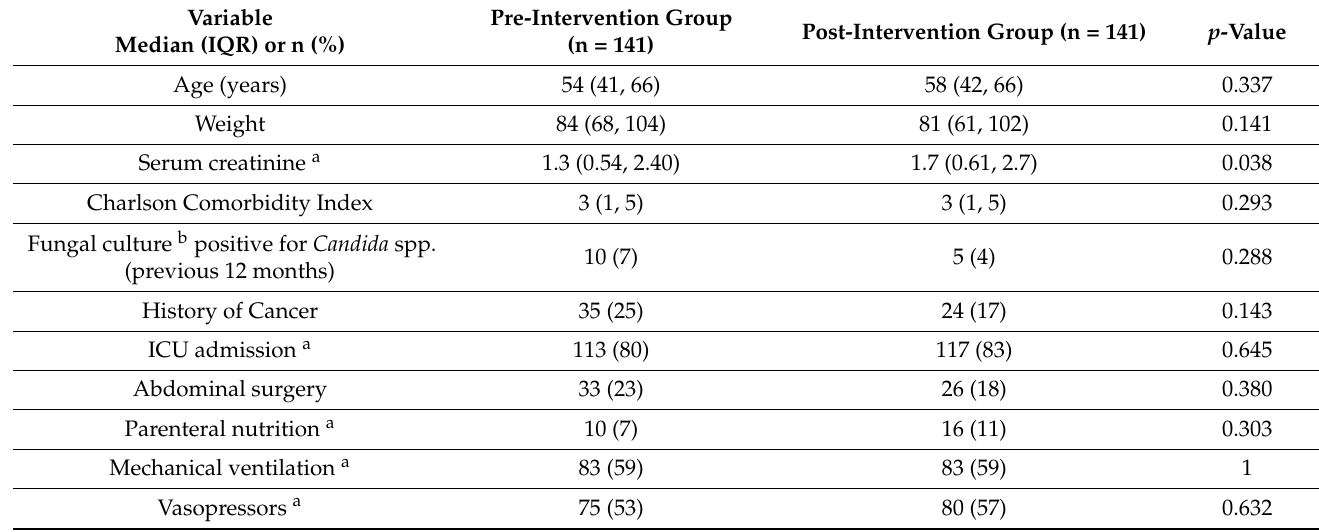
Table 1. Baseline characteristics of included participants.